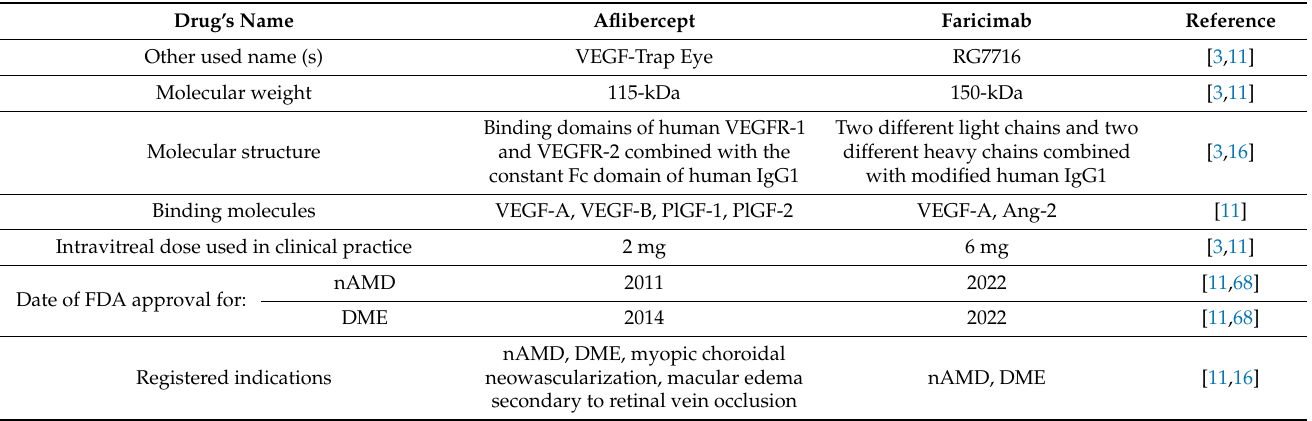
Table 1. Comparison of general information and pharmacological properties for aflibercept and faricimab.